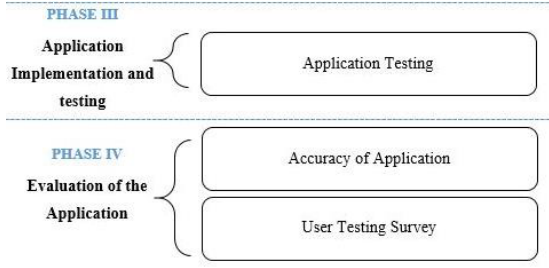
Figure 1. Mobile Application Development flowchart